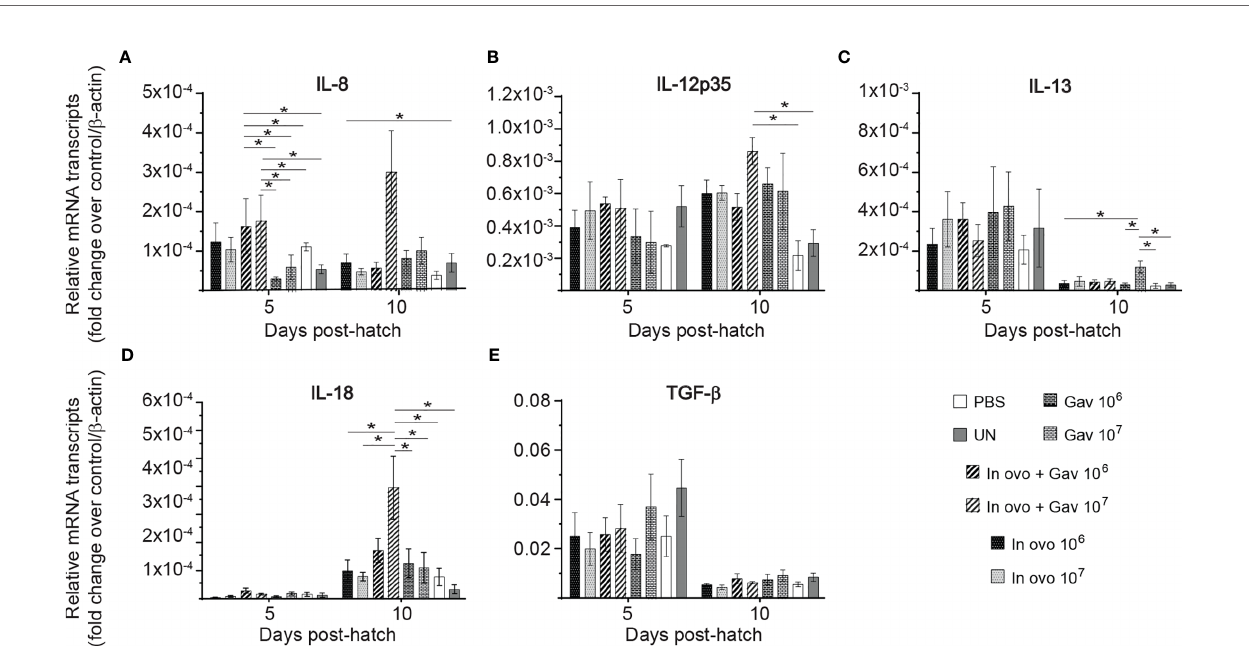
FIGURE 4 | Relative gene expression in the bursa of Fabricius of chickens inoculated with lactobacilli. The bursa of Fabricius samples were collected at days 5 and 10 post-hatch from all treatment groups: groups 1 and 2 received 10 6 and 10 7 CFUs of lactobacilli cocktail in ovo , respectively, at embryonic day eighteen; groups 3 and 4 received 10 6 and 10 7 CFUs of lactobacilli, respectively, via both in ovo and oral gavage (on days 1, 7, 14, 21, 28 post-hatch); groups 5 and 6 received 10 6 and 10 7 CFUs of lactobacilli, respectively, via oral gavage; group 7 was served as a negative control group and was injected with phosphate-buffered saline (PBS); group 8 remained untreated (UN). Fold change was used to characterize differences in gene expression of IL-8, IL-12, IL-13, IL-18 and TGF- b (A – E) , in comparison to negative control group. Statistical signi fi cance among treatment groups was calculated using SAS Proc GLM (General Linear Model) followed by Tukey ’ s comparison test. Error bars represent standard errors of the mean. Results were considered statistically signi fi cant if P < 0.05. Bars with asterisks represent a signi fi cant difference among treatments. The data are representative samples from 6 individual